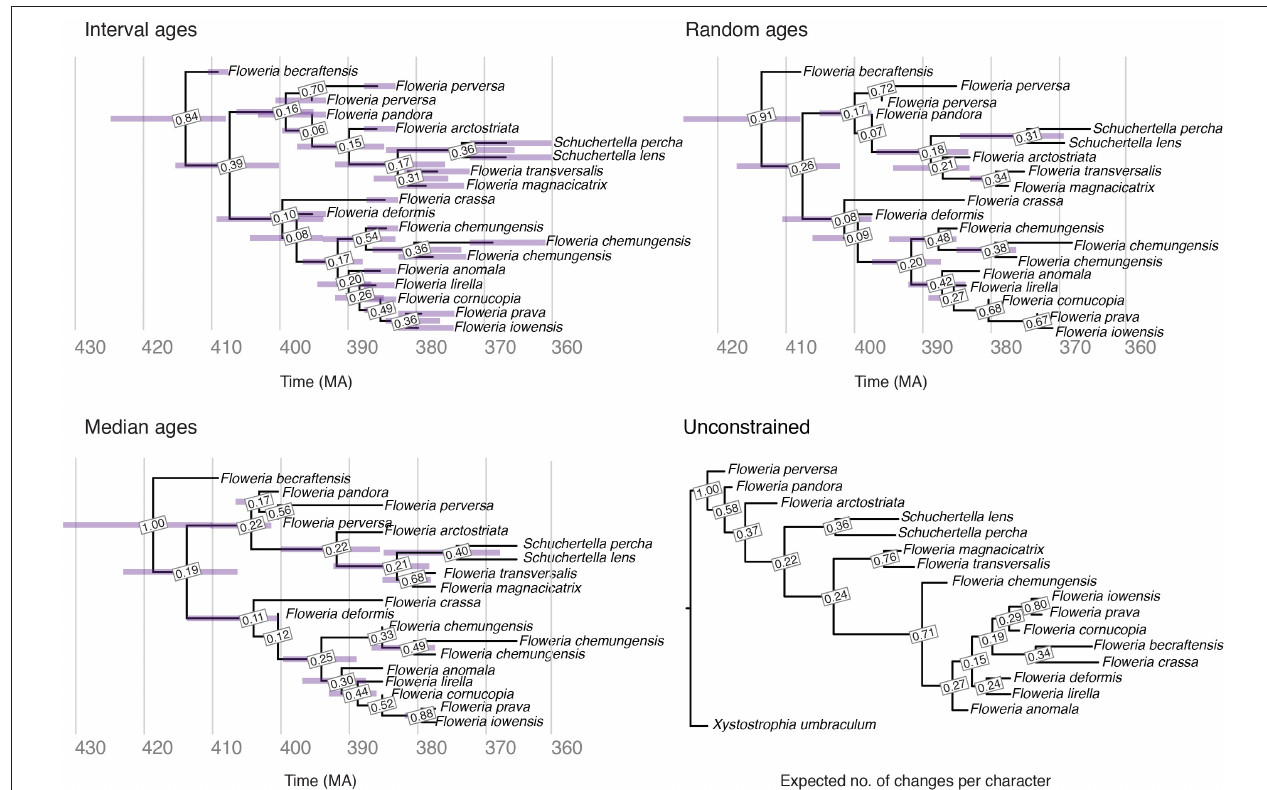
FIGURE 6 | Brachiopod MCC trees obtained using the FBD analysis with interval ages, median ages and random ages, and unconstrained analysis. Posterior support is shown for each node for all trees. Error bars on the FBD trees show the 95% HPD interval for the age of each node, as well as the age of each fossil in the tree with interval